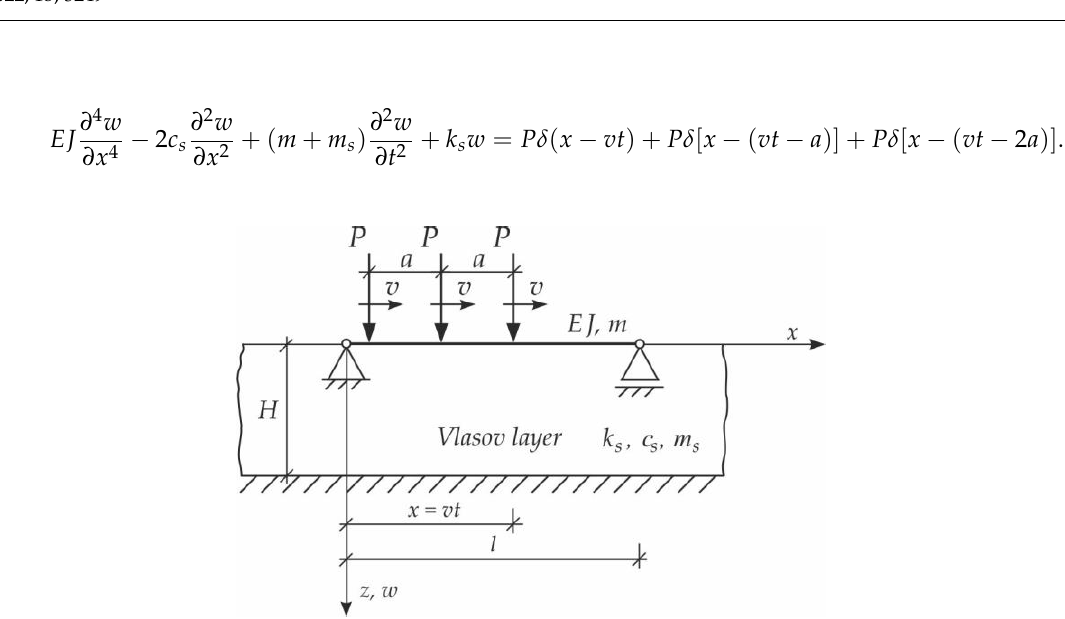
Figure 14. Beam on Vlasov foundation subjected to a group of three moving forces spaced at a constant distance a .